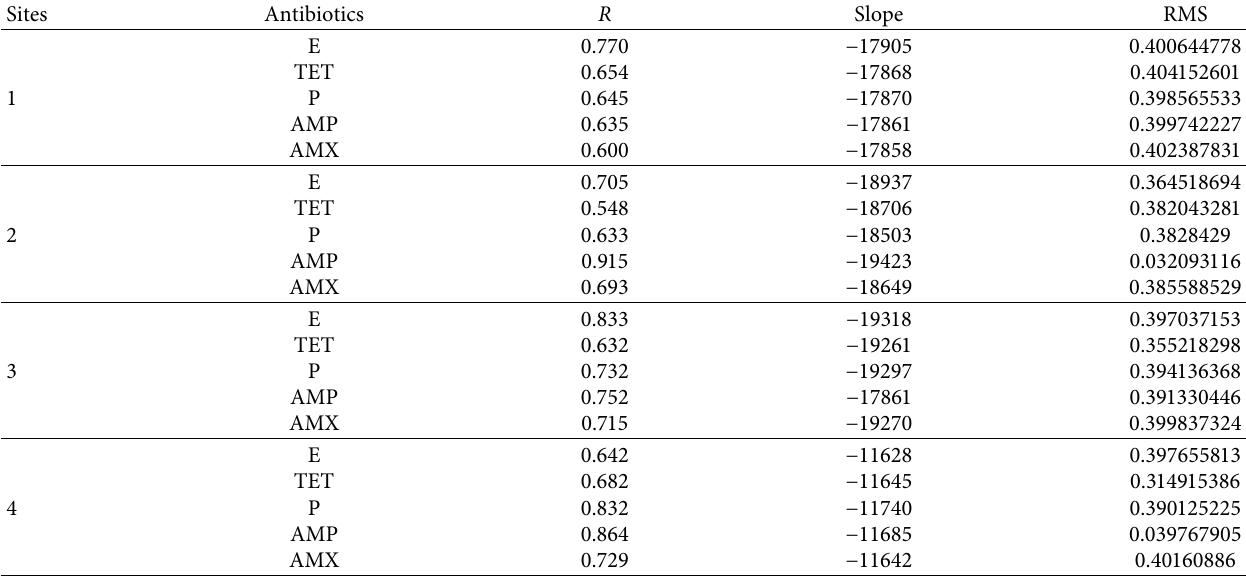
Table 2: Correlation coefcient ( R ), slope, and residual mean square (RMS) values were obtained for the exponential decay model for hospital wastewater at diferent concentrations of